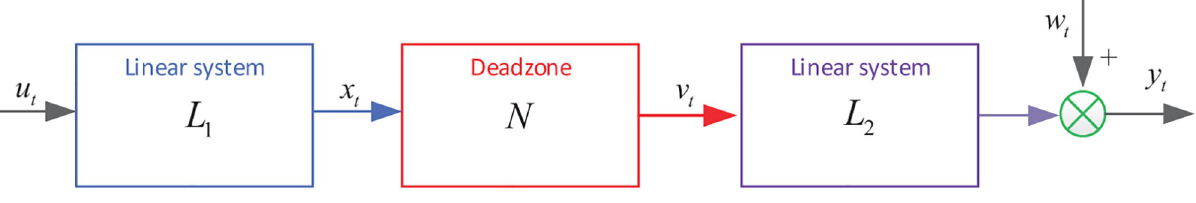
Fig 1. Nonlinear sandwich